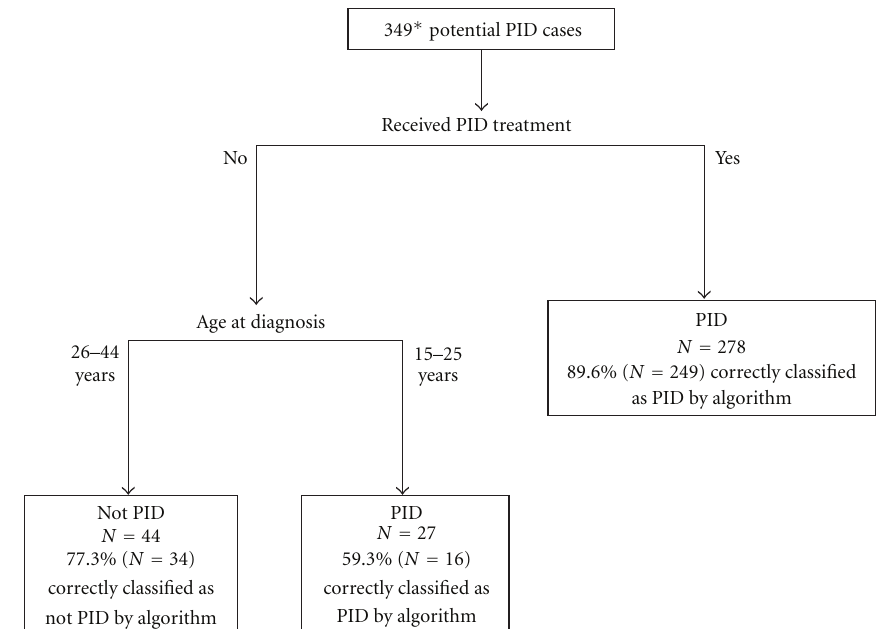
Figure 1: Case-finding algorithm developed using automated administrative data from Group Health Cooperative to refine identification of PID among a sample of women with ICD-9 codes suggestive of PID. PID: pelvic inflammatory disease. ∗ Of 393 potential PID cases with ICD-9 codes associated with PID, 44 were not included due to uncertainty of PID case status after medical record